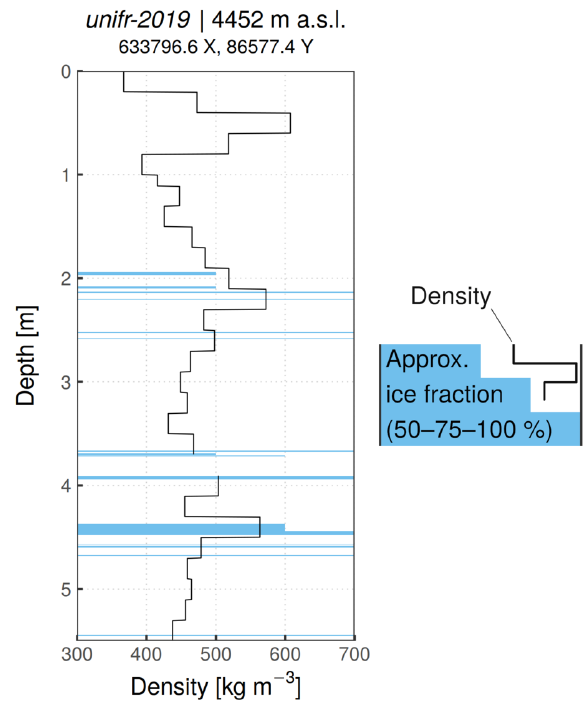
Figure A1. Density and stratigraphy of firn core unifr-2019 . Val- ues between 3.7 and 3.9m are missing due to broken core during recovery. Drilling location is in metric CH1903/LV03